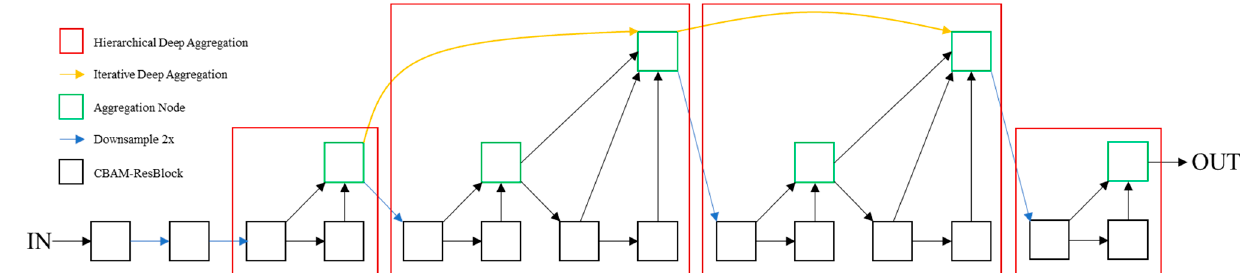
Figure 6. Structure of CBAM-DLA34.